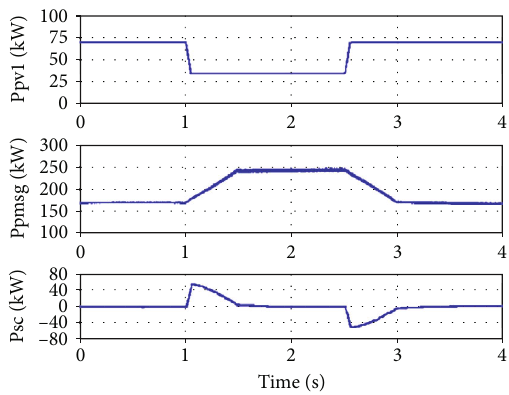
Figure 14: Output powers of a PV array, MTG, and SC during irradiance changes.